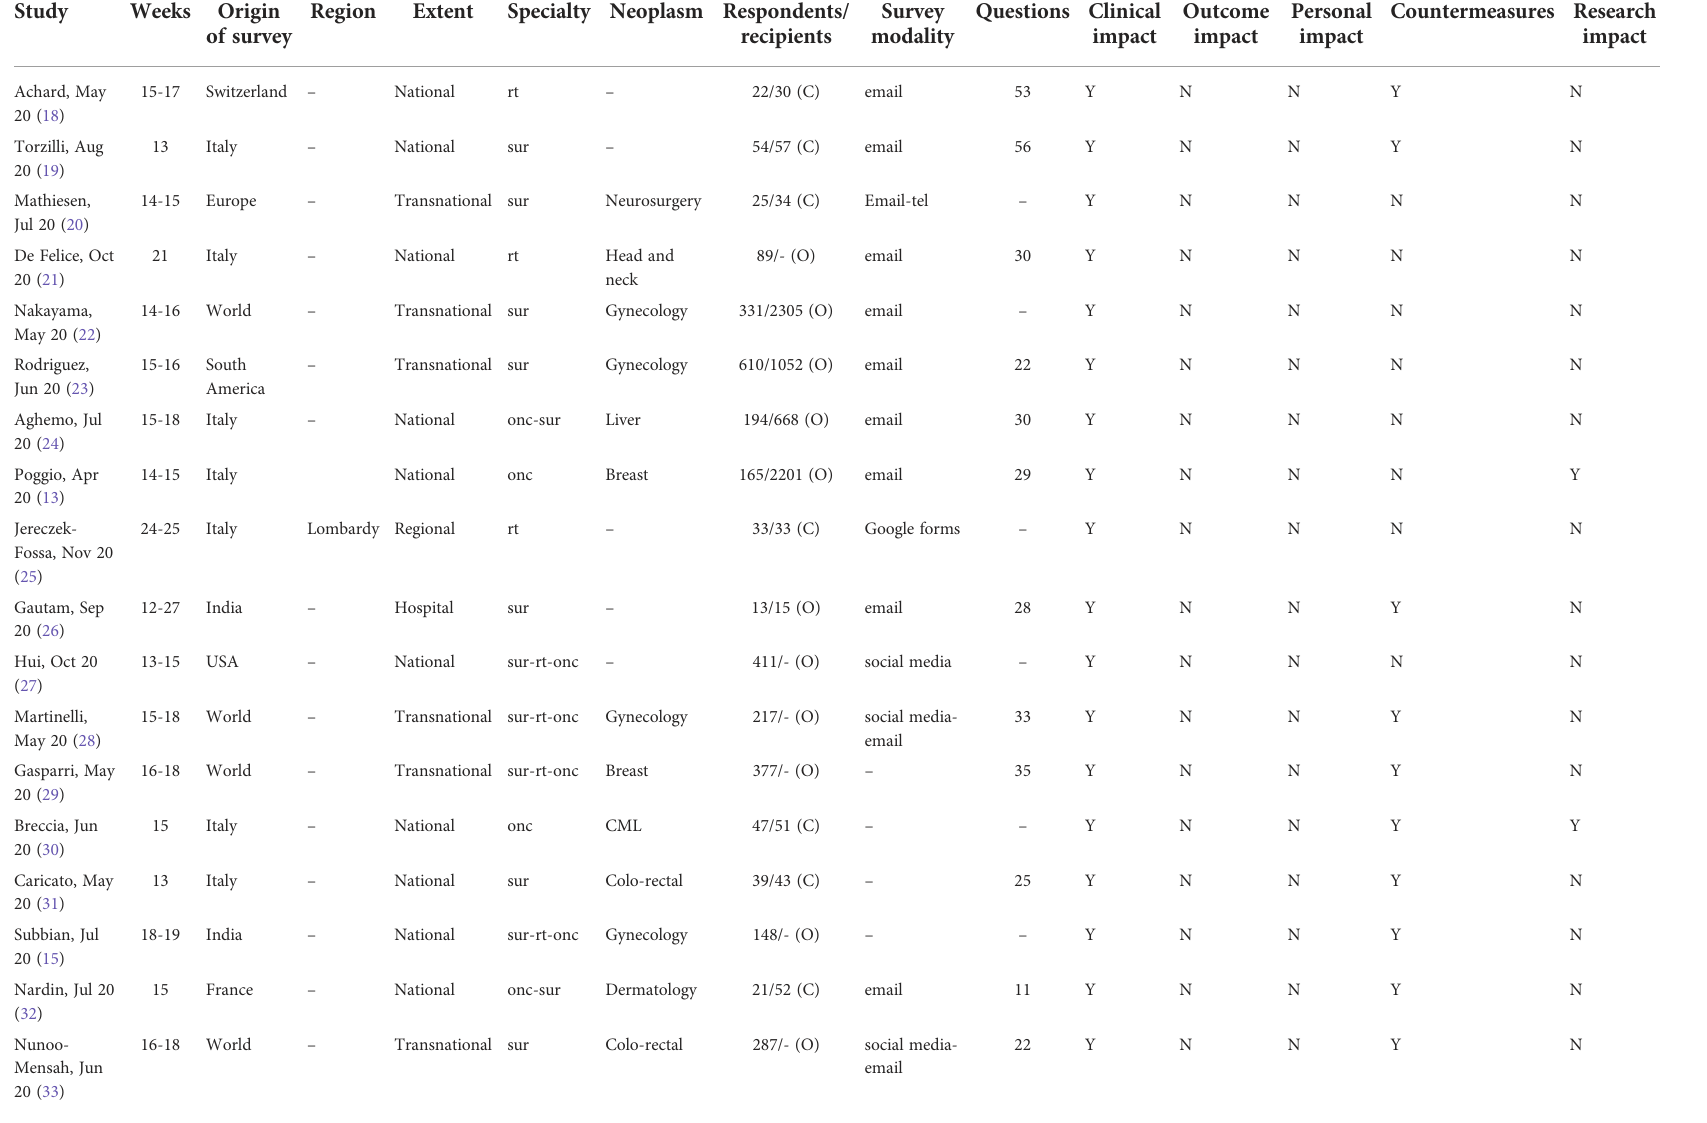
TABLE 1 Characteristics of the studies included in the systematic